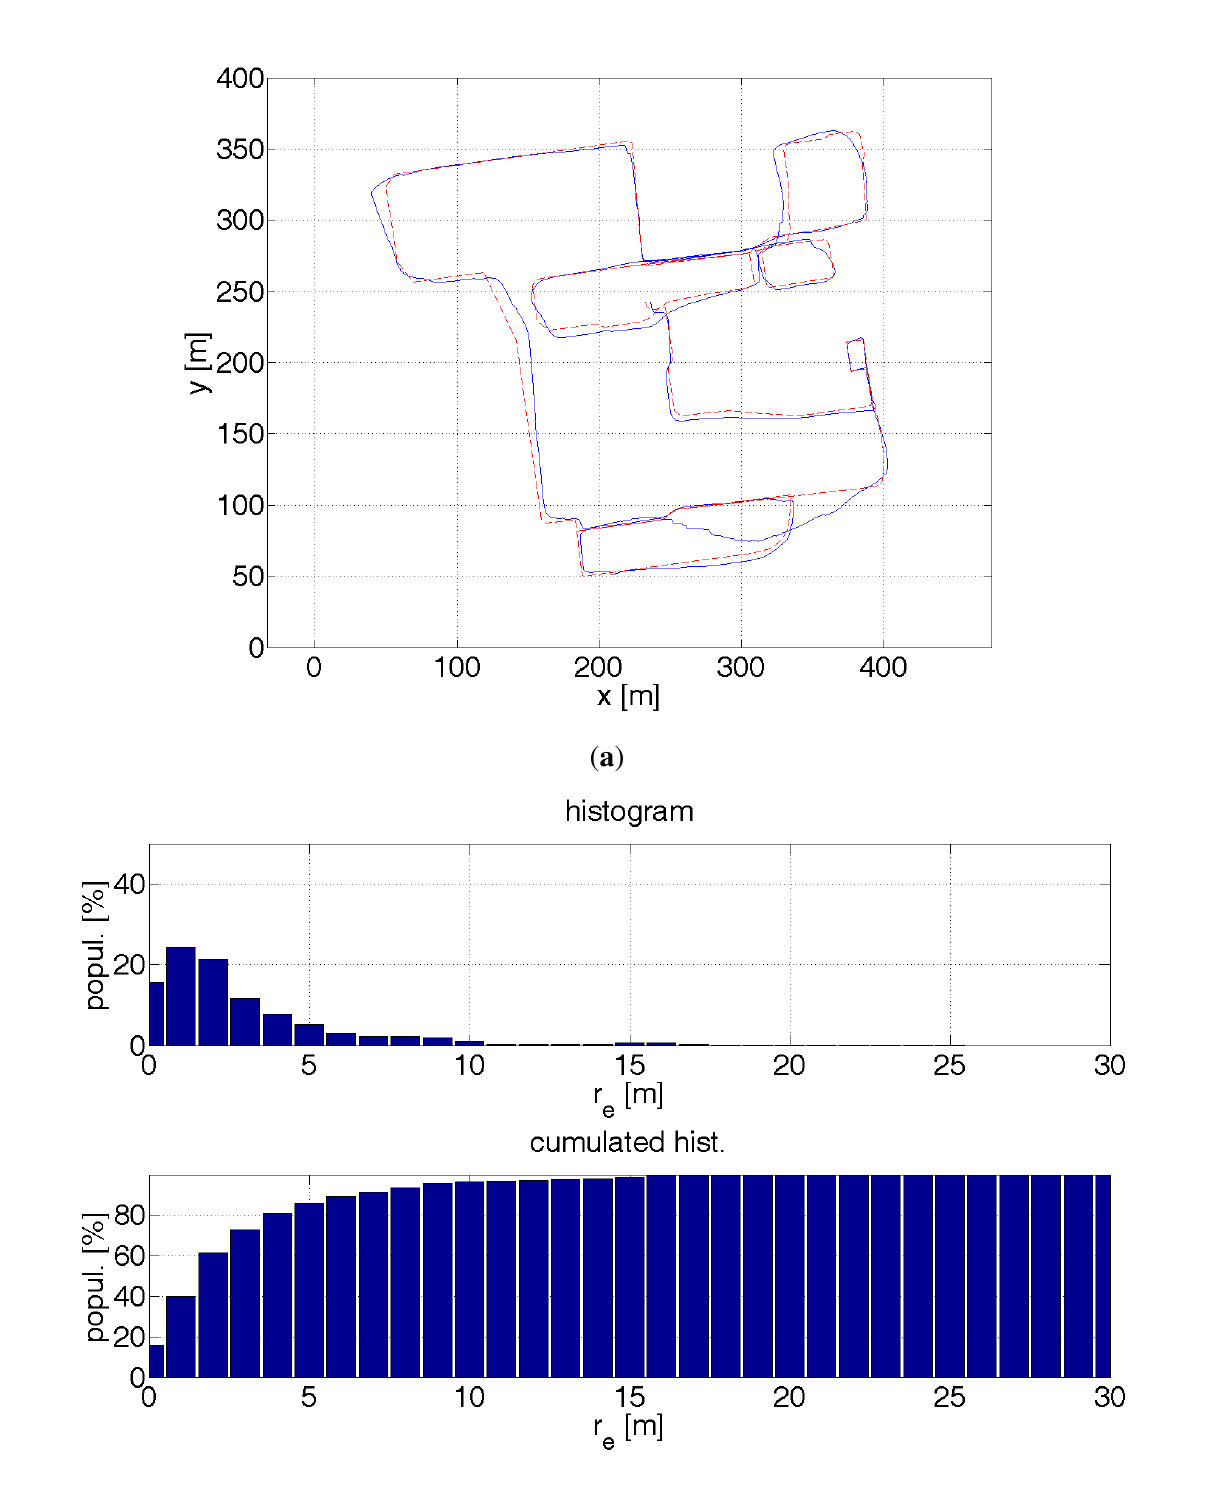
Figure 21. ( a ) Red dashed line—reference path. Blue solid line—estimated path with a help of GPS receiver, inertial sensors, probability map, stereo camera and 3D model of the environment. The error of estimating direction at (400 m , 120 m ) introduces big errors later on. The filter managed to recover at (240 m , 80 m) . ( b ) Histograms of distance